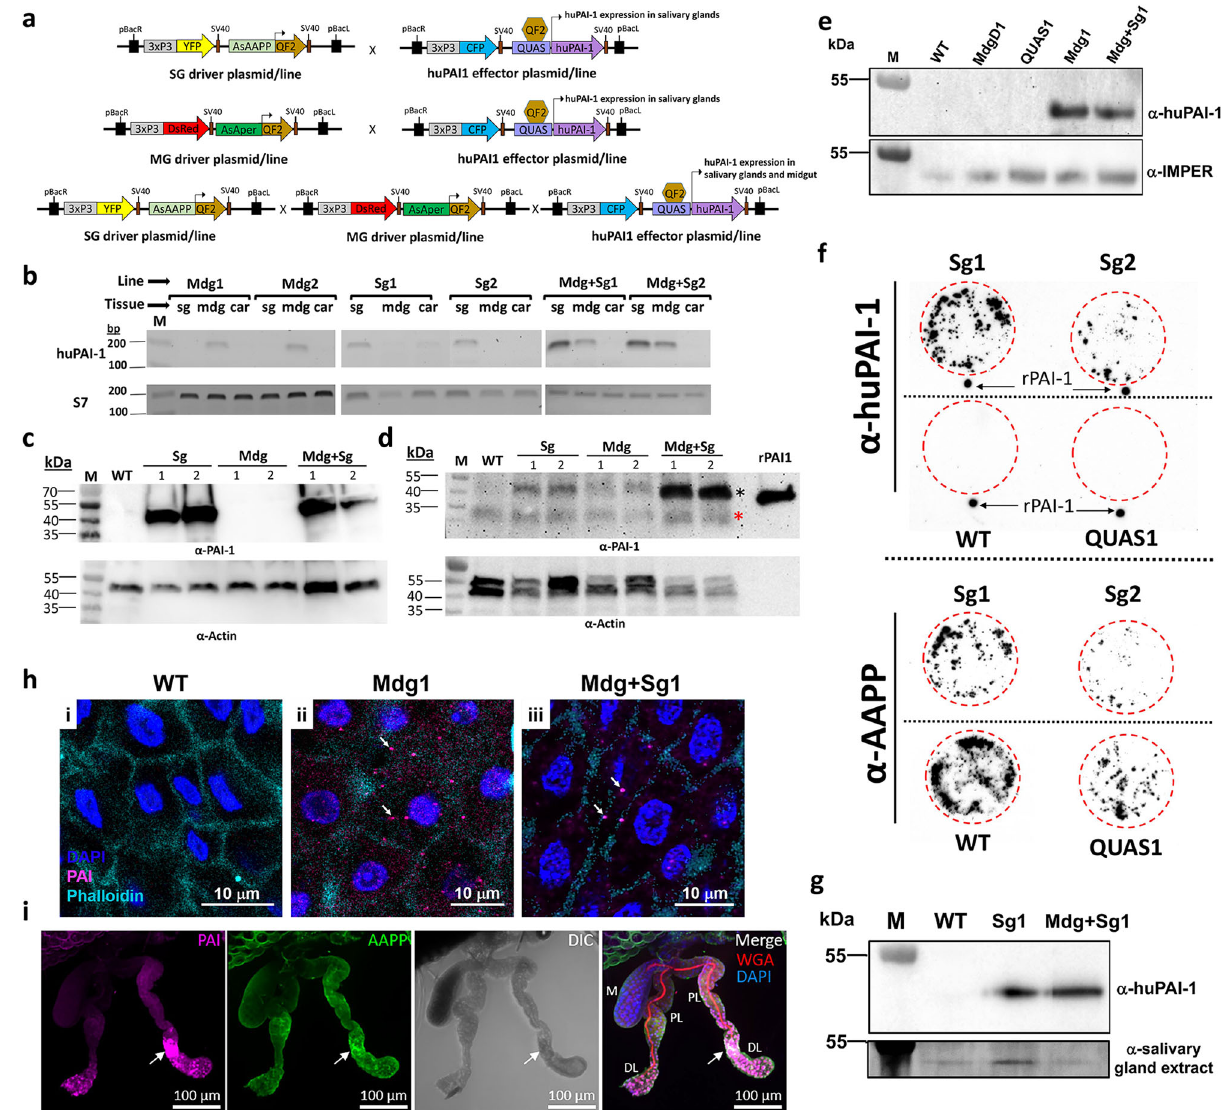
Fig. 1 Tissue-speci fi c expression of huPAI-1 in transgenic An. stephensi mosquitoes. a Schematic of the plasmids used to develop the driver and effector parental lines. In the driver lines, the QF2 transcription factor is expressed by the AsAAPP promoter or the AsAper promoter in the salivary glands or the midgut, respectively. Crossing the driver and the effector lines (Supplementary Fig. 2c) induces salivary gland- (SG) and/or midgut- (MG) speci fi c expression of human PAI-1 (huPAI-1). Transgene integration in the genome was mediated by the inverted terminal repeats of piggyBac (pBacR and pBacL). SV40: transcription terminator sequence. b Tissue-speci fi c expression of huPAI-1 mRNA detected by RT-PCR in the midgut (mdg) and salivary glands (sg) of transgenic female mosquitoes. Carcasses (car) were used as negative controls. The ribosomal protein S7 was used as positive control. Mdg1 and Mdg2: huPAI-1 midgut transgenics, Sg1 and Sg2: huPAI-1 salivary gland transgenics, Mdg + Sg1 and Mdg + Sg2: huPAI-1 midgut and salivary gland transgenics. c , d Immunoblotting showing huPAI-1 protein expression (47 kDa) in salivary gland ( c ) and midgut ( d ) lysates from transgenic lines. Recombinant huPAI-1 (rPAI-1) was used as a positive control. WT wild type, M molecular size marker. The black asterisk in ( d ) points to the huPAI-1 speci fi c bands and the red asterisk points to a non-speci fi c band. e Midgut lumen huPAI-1 secretion was assessed by the low-melting agarose assay. Liquid low-melting agarose was fed to mosquitoes and after solidi fi cation, secreted proteins trapped in the midgut agarose bolus were analyzed by Western blotting with an anti-huPAI-1 antibody. An α -IMPer antibody was used as a positive control for a midgut secreted protein. M marker, MdgD1 midgut QF2 parental line, QUAS1 QUAS- huPAI-1 effector line. f “ Spit-blot assay ” showing secretion of huPAI-1 in the saliva. Mosquitoes were allowed to probe on a pre-heated nitrocellulose membrane. Membranes were analyzed by immunoblotting with an α -huPAI-1 antibody or an anti-AAPP antibody as a positive control. WT and QUAS1 parental mosquitoes were used as negative controls. Red-dashed circles show the probing area. Recombinant huPAI-1 was spotted outside the probing area as a positive control. g huPAI-1 is detected in the midgut lumen of Sg1. Ingestion of saliva containing huPAI-1 was con fi rmed by low melting agarose assay, followed by immunoblotting with an α -huPAI-1 antibody. An α -salivary gland extract antibody was used as a control for ingested saliva proteins. M marker. h Detection of huPAI-1 in the midgut of the WT (i), Mdg1 (ii), and Mdg + Sg1 (iii) lines. arrows: huPAI-1 staining in cytoplasm. i Localization of huPAI-1 expression in salivary glands of one-day-old Sg1 females stained with DAPI (DNA, blue), WGA (red), anti-AAPP (green) and anti-PAI-1 (purple). AAPP and PAI-1 signals localized throughout the salivary glands, with the highest levels observed in the proximal portion of the distal lateral lobes (arrow). DL distal lateral, M medial, PL proximal lateral. Data presented in panels ( b – i ) are representative of at least two independent experiments. Source data are provided as a Source Data fi le.